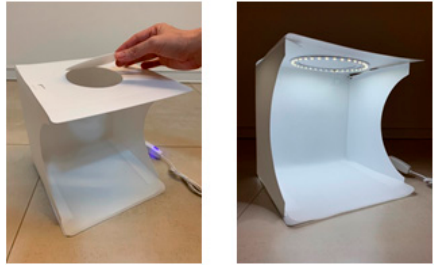
Figure 2. Studio for sample capture .